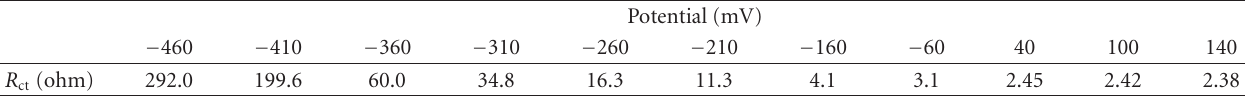
Table 2: Charge transfer resistance ( R ct ) for methanol oxidation on Pt-Pd/C electrode in a solution containing 0.5MNaOH and 1.0 M methanol at various potentials.